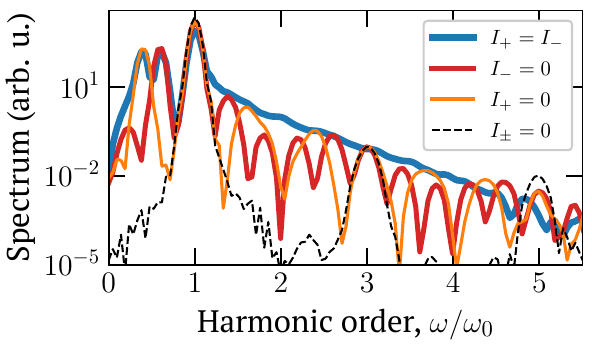
Figure 3. d j / dt squared spectrum from one-color (black dashed line), two-color (red and orange lines) ∆ ω = ω 0 /2 and three-color (blue line) ionizing pulses with ω 0 corresponding to λ 0 = 800 nm, ω ± ± with ∆ ω = ω 0 /10. The pulse intensities are chosen so that the degree of gas ionization is approxi- = 2 mately the same: I 0 = 10 15 W/cm 2 , I + = I 10 14 W/cm 2 (blue line); I 0 = 1.5 10 15 W/cm 2 , × × − = 2 = 0 (red and orange lines, respectively); I 0 = 2 = 0 I 10 14 W/cm 2 , I 10 15 W/cm 2 , I + = I × × ± ∓ − = (black dashed line). Pulse duration τ p = 20 fs, phases ϕ ±